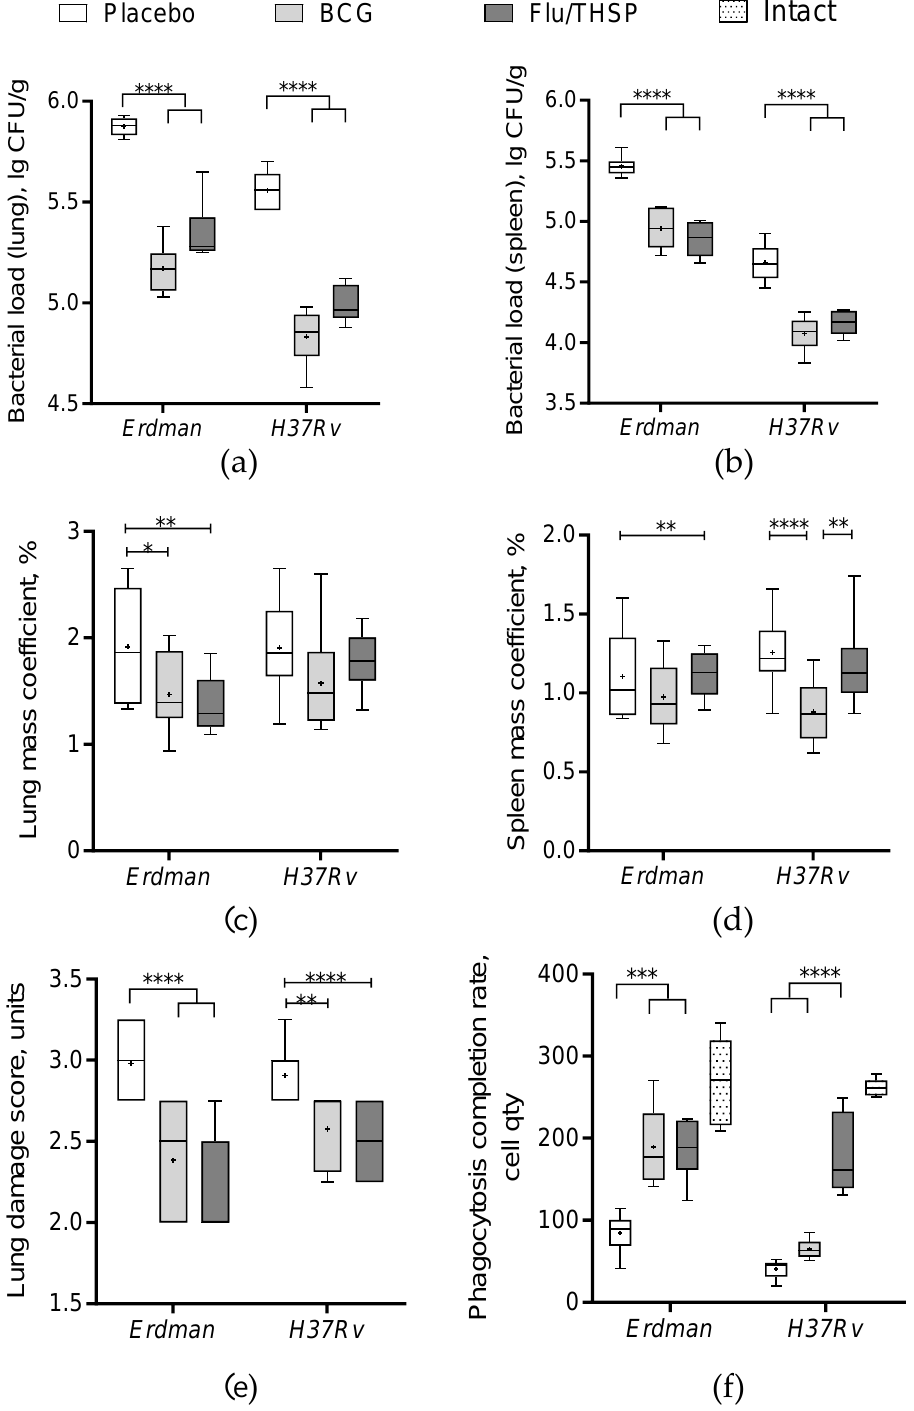
Figure 4. Protective efficacy of Flu/THSP in a mouse model of TB infection. Protective efficacy of Flu/THSP vaccinated mice six weeks post TB infection. Mice were immunized with Flu/THSP or BCG or placebo (indicators are shown on top), challenged with virulent M. tb Erdman or H37Rv strain as indicated, and analyzed six weeks post-infection. ( a , b ) Bacterial load in lungs and spleen was measured by titration of tissue homogenates; ( c , d ) Lungs and spleen mass coefficients were estimated as the percentage of organ weight relative to body weight; ( e ) The lung damage score was quantified in conventional units as described in Section 2.6; ( f ) Phagocytosis completion rate of model yeast cells was measured. Statistical analyses were performed by two-way ANOVA, and the results of the Bonferroni post-hoc-test for a pairwise comparison are presented by asterisks (* p < 0.05, ** p < 0.01, *** p < 0.001, and **** p < 0.0001).